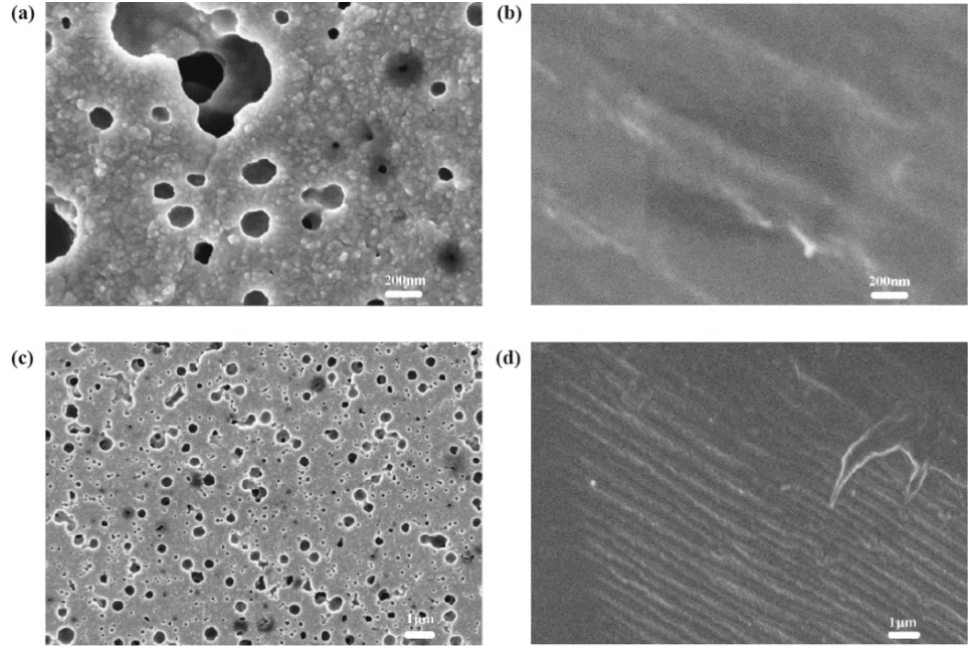
Figure 3. SEM images of the TiO 2 layer prepared by Kronoclean 7404: ( a ) and ( c ) are the surface with a magnification of 50,000 times and 8000 times, respectively; ( b ) and ( d ) are the cross-section with a magnification of 50,000 times and 8000 times, respectively.